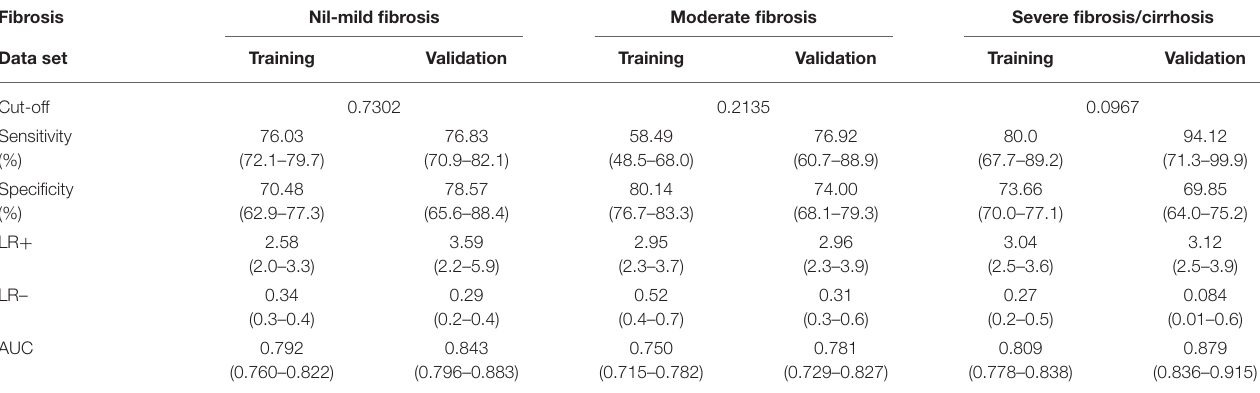
TABLE 4 | The detail information of the multinoimal nomogram in predicting of fibrosis.